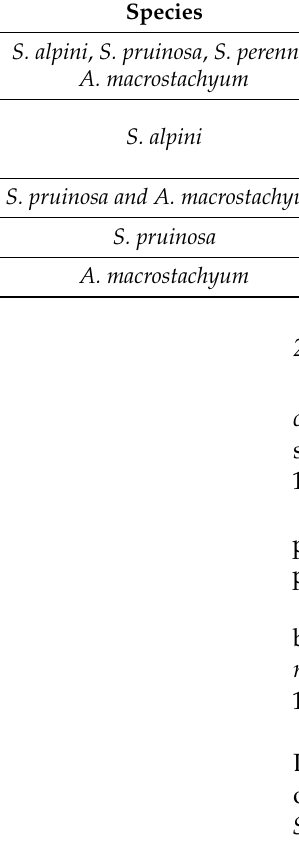
Table 2. Tentative identification of flavonoids in Sarcocornia and Arthrocnemum . Species Flavonoid